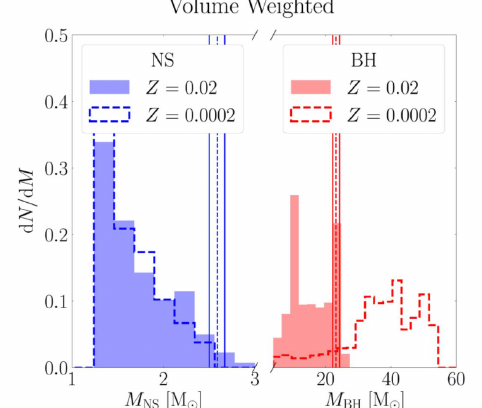
Figure 11. Merging NS–BH binaries formed via binary–single encounters in dense clusters and corrected for ground-based GW detectors. Vertical lines correspond to the median value (dashed line) and 95% confidence level boundaries (straight lines) of the mass of GW190814 source components. Taken from Figure 4 in Arca Sedda, ApJL, 2021, 908, L38 ©AAS [136]. Reproduced with